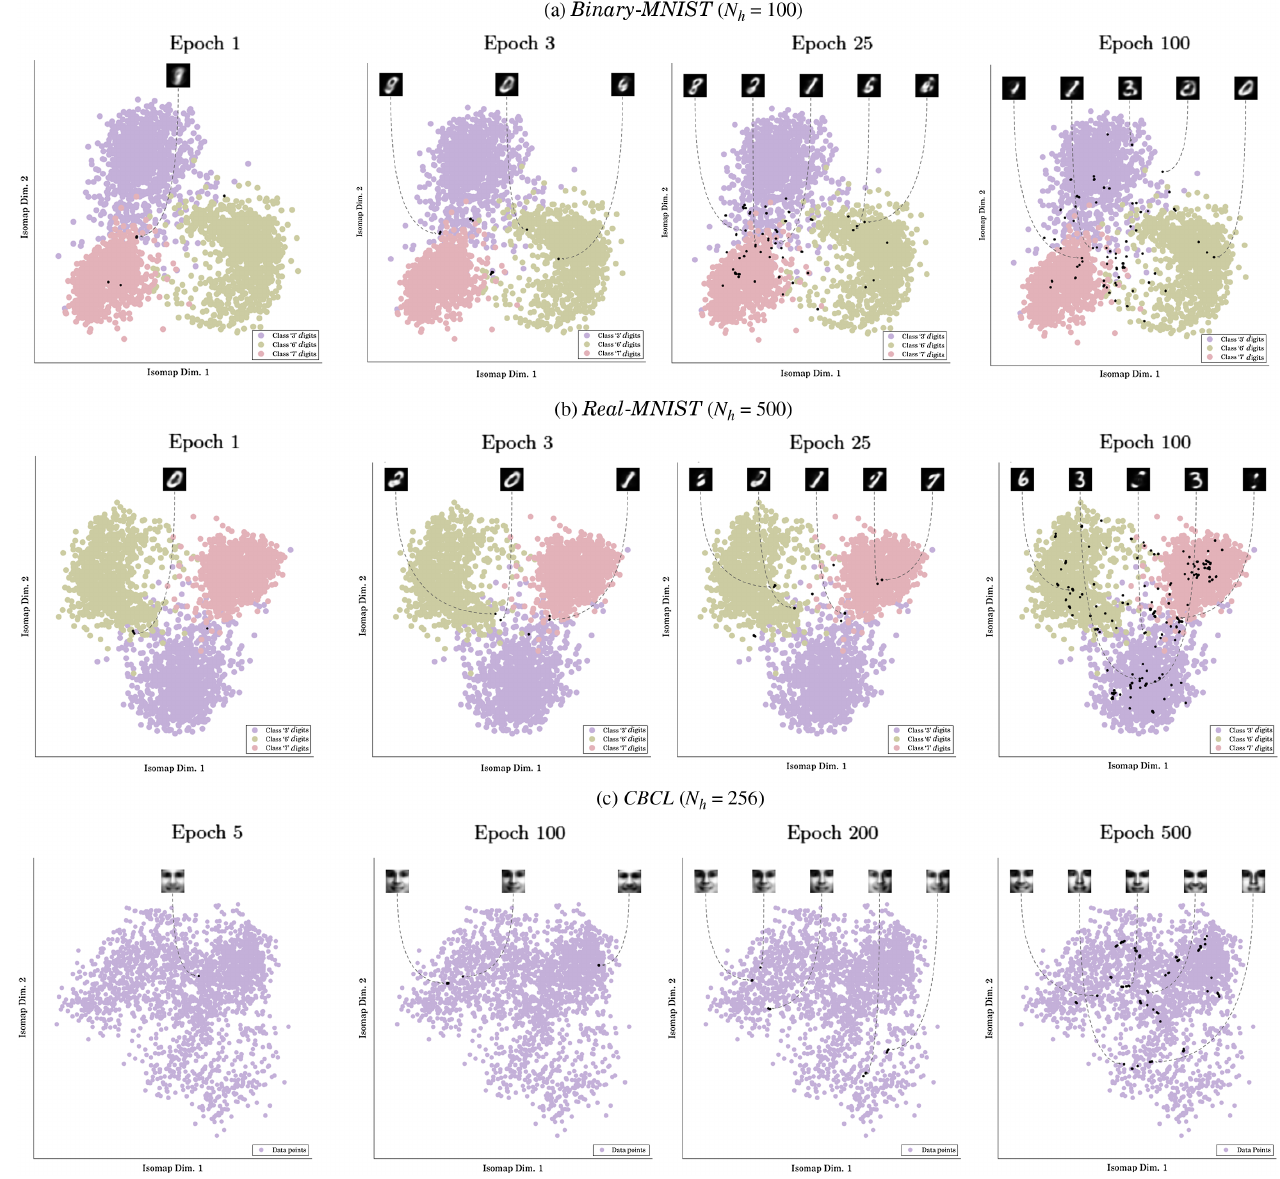
FIG. 7. Comparison of initial conditions for TAP equilibration (colored dots) compared to converged TAP solutions (black dots) for the tested data sets at different stages of training. For each data set, a two-dimensional Isomap embedding is calculated over the initialization data. Subsequently, the magnetizations of the TAP solutions are embedded in the same space. In each case, all initial variances are set to 0, as in Eq. (38). Also, a random selection of TAP solution magnetizations are chosen to provide some context for the representations the RBM is learning. (a) Binary MNIST: Here, the approximately 3100 digits corresponding to the classes “ 3, ” “ 6, ” and “ 7 ” are drawn from the first 10 000 training samples of the binarized MNIST data set as initializations. A reduced set of labels is used for readability. (b) Real MNIST: The same initializations are used as in (a); however, the initializations are not binarized. (c) CBCL: All available training face images are used as